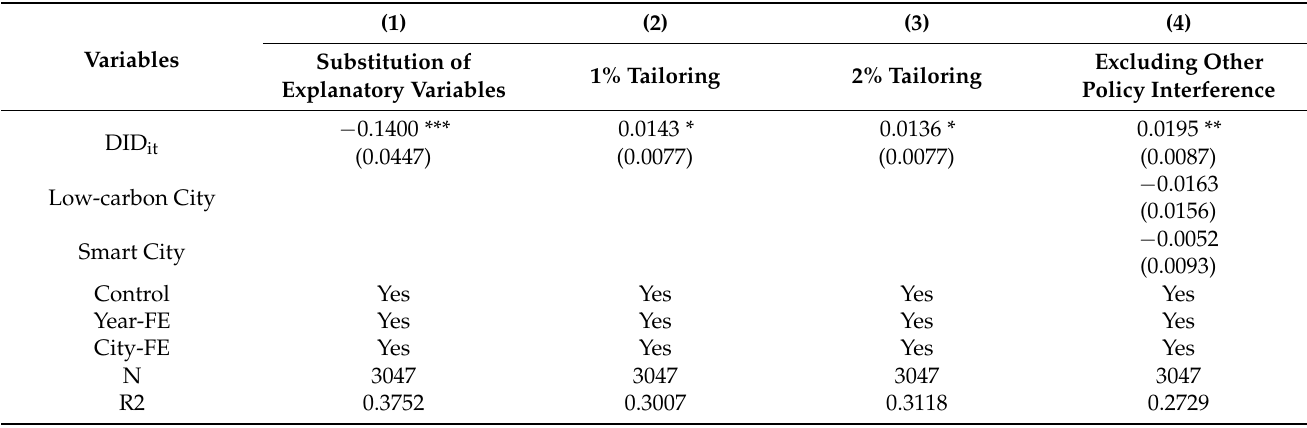
Table 5. Robustness